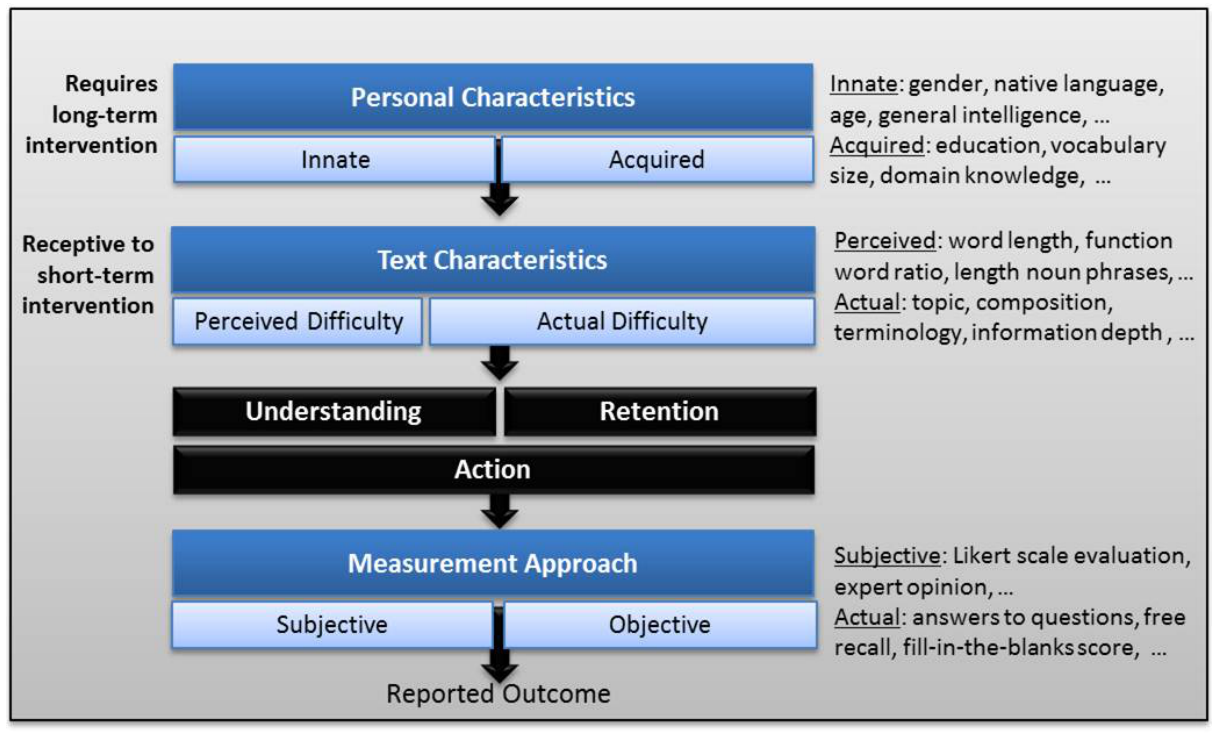
Figure 1. Factors that influence understanding and retention of